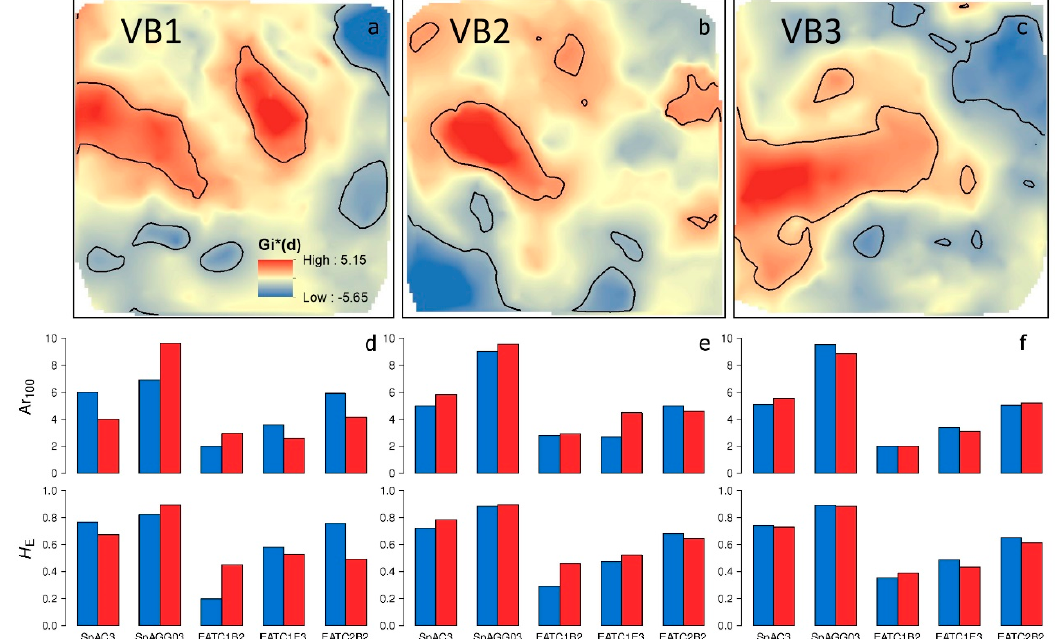
Figure 3. Interpolated and z -transformed local Gi*(d) values computed for tree age for 10 m distance interval at ( a ) VB1, ( b ) VB2 and ( c ) VB3. Red and blue areas are hot spots (i.e., groups of trees with age higher than the average within the plot) and cold spots (i.e., groups of trees with age lower than the average within the plot), respectively. Colour scale is proportional to the value of the local Gi*(d) index. Bold contour lines indicate significant clusters ( p < 0.005). Values of genetic diversity parameters ( H E and Ar 100 ) at each locus for individuals within hot and cold spots at ( d ) VB1, ( e ) VB2 and ( f ) VB3.